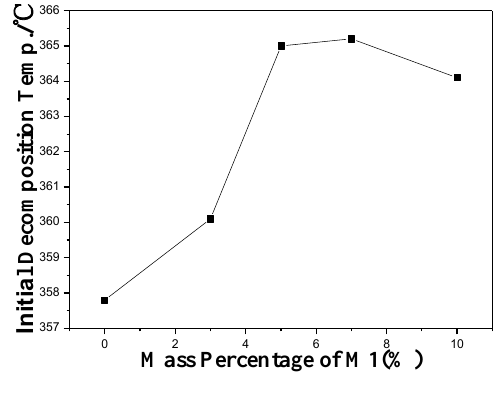
Figure 5. Initial decomposition temperature vs .